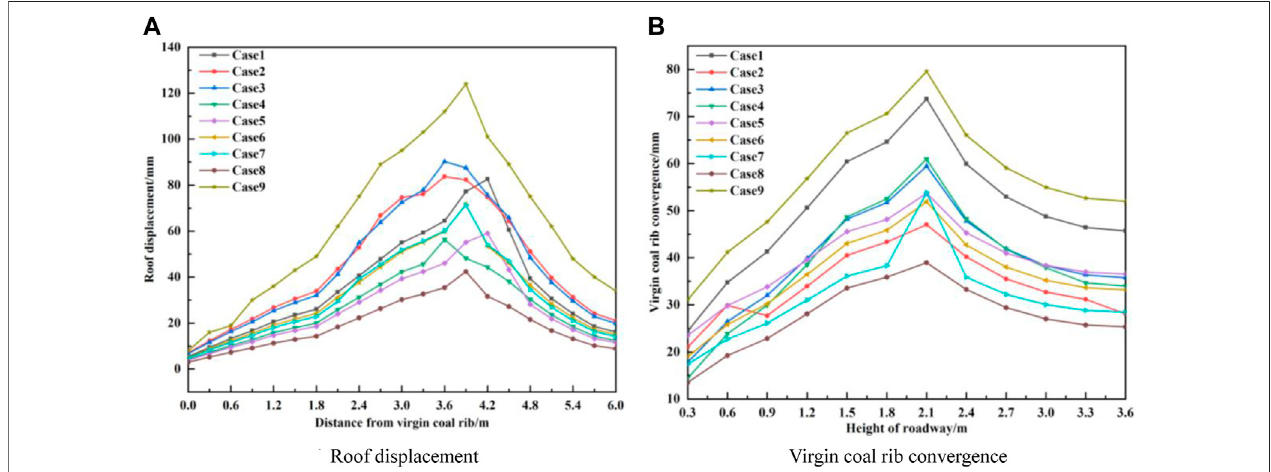
FIGURE 15 | Deformation of the surrounding rock of the roadway at different angles and height of roof cutting. (A) Roof displacement (B) Virgin coal rib convergence.